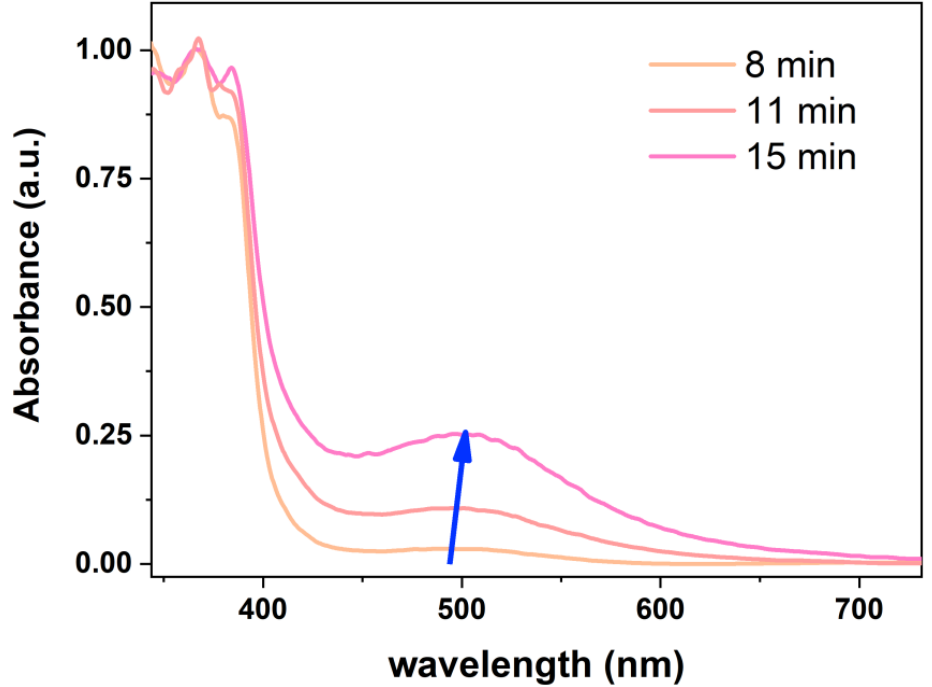
Figure 7. Time-monitored solid UV-vis spectra displaying the plasmonic absorption in the formation process of AuAg-g- C 3 N 4 nanohybrid ( 3 ). The blue arrow indicates a slight red-shift of the plasmonic absorption with time.